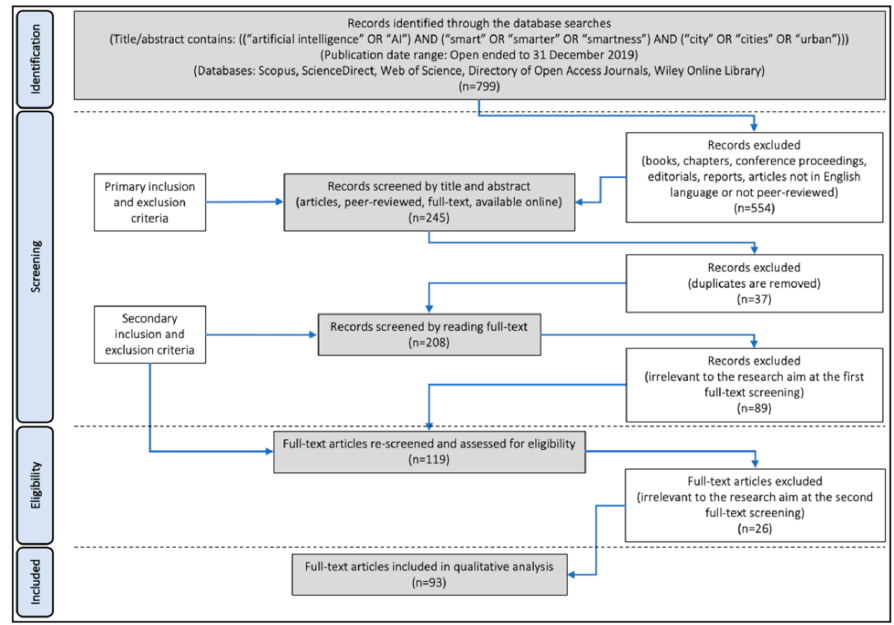
Figure 2. Literature selection procedure.